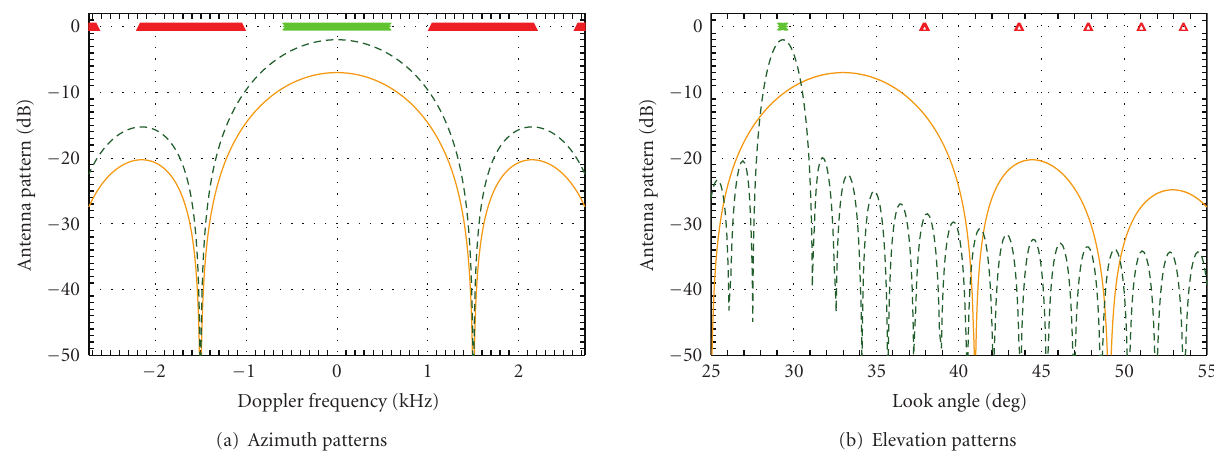
Figure 7: Transmit (solid line) and receive patterns (dashed line) of the planar antenna system in azimuth and elevation. All patterns are normalized to the maximum gain of the uniformly tapered receive